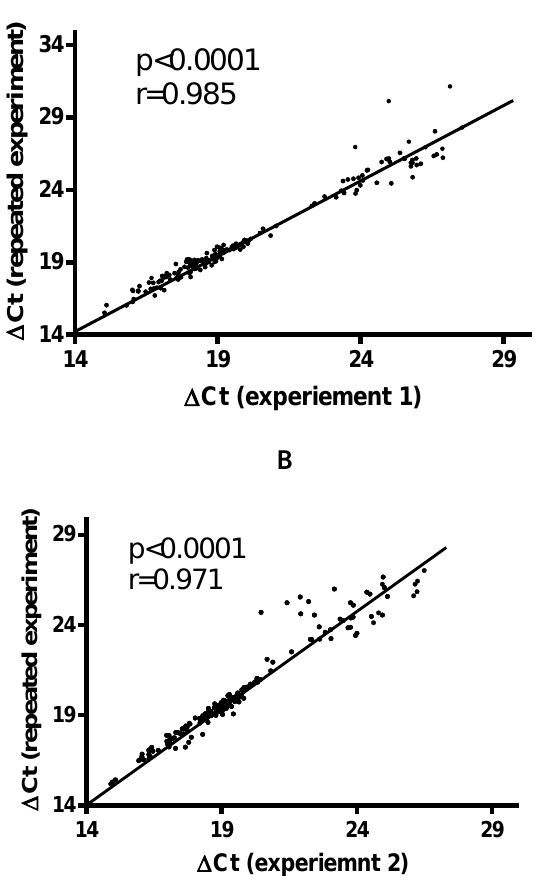
Figure 1. Viability of cardiomyocytes exposed to sodium arsenite. AC16 cells were seeded in a 96-well plate and exposed for three days to various concentrations of sodium